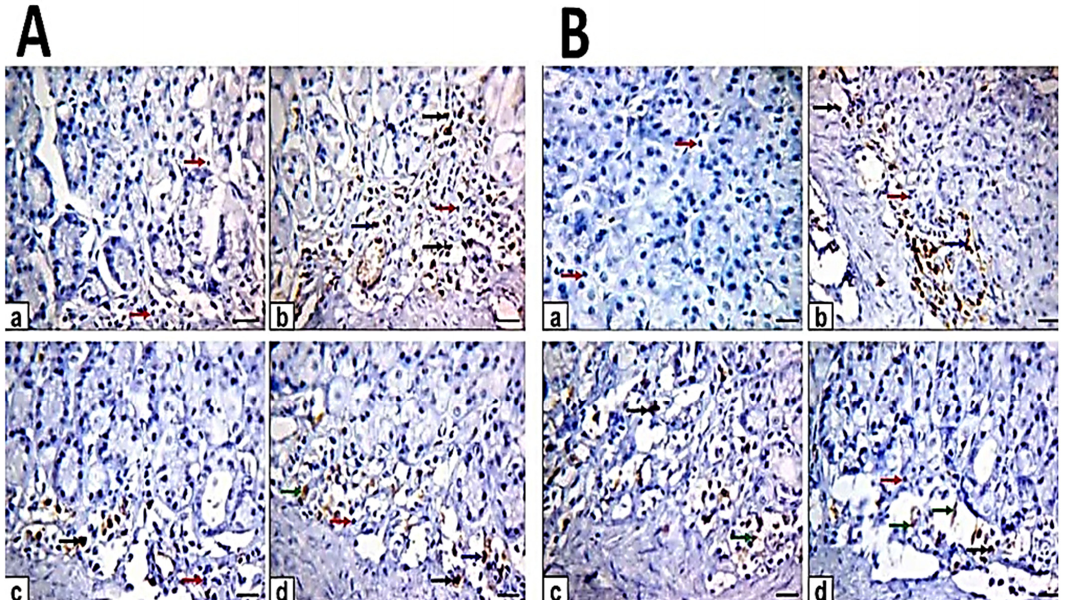
Figure 7. Photomicrographs of immunohistochemical staining of tumor necrosis factor-alpha (TNF- α ) protein expression in gastric section. Scale bar = 100 µm. ( A ) The gastric sections of the pretreatment group: ( a ) control rats, ( b ) ethanol- induced ulcer rats in one hour, ( c ) MO-pretreated (MO-EtOH) rats, ( d ) ME-pretreated (ME-EtOH) rats. Arrows in the panels are showing strong (black arrows), moderate (blue arrows), weak (green arrows), and negative (red arrows) brown immunoreactions. ( B ) The gastric sections of the treatment group: ( a ) control rats, ( b ) ethanol-induced ulcer rats on day 7, ( c ) MO-treated (EtOH-MO) rats, ( d ) ME-treated (EtOH-ME) rats. Arrows in the panels showed strong (black arrows), moderate (blue arrows), weak (green arrows), and negative (red arrows) brown immunoreactions.